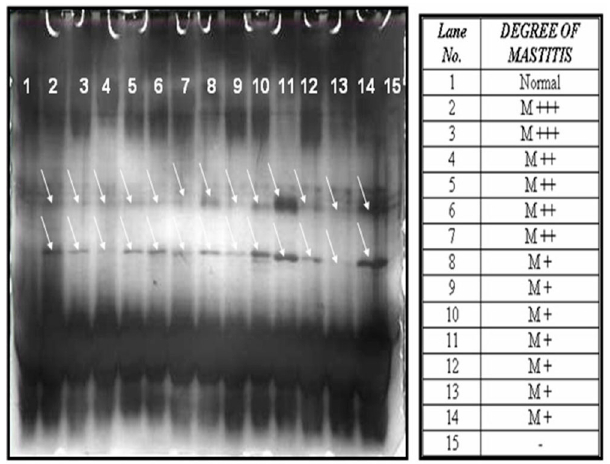
Figure 1. The 12% SDS-PAGE analysis of the whey protein of bovine milk (normal and mastitis milk) and silver staining.